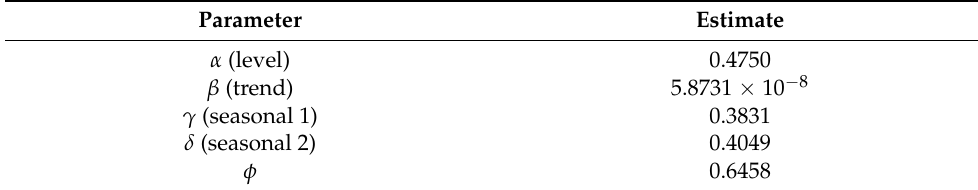
Table 1. Parameter estimations of Taylor’s adjusted double seasonal exponential smoothing model.